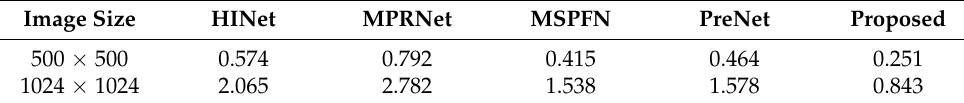
Table 5. Comparison of running time (sec) on NVIDIA GTX 1050Ti GPU. Image Size